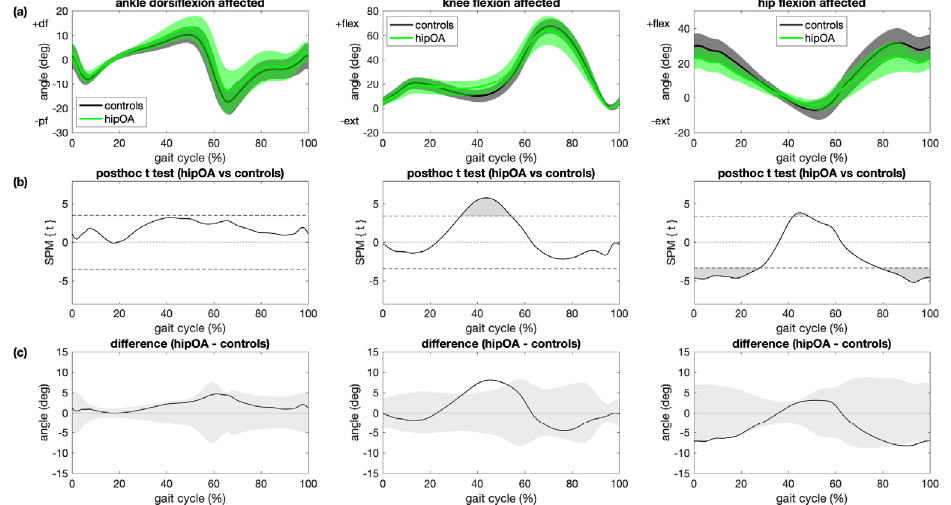
Figure 3. Comparison between patients with hip OA and controls. ( a ) Mean and 1 standard deviation joint angle trajectories for ankle dorsiflexion (left), knee flexion (center) and hip flexion (right) angle for the affected/left leg for patients with hip OA (green) and controls (black); ( b ) results of statistical parametric mapping with posthoc t tests (SPM{t}) where regions with statistically significant difference between groups are indicated as grey regions ( p < 0.05/3); ( c ) mean joint angle deviation from the control group for patients with hip OA where grey areas illustrate ± 1 SD of the joint angles of the control